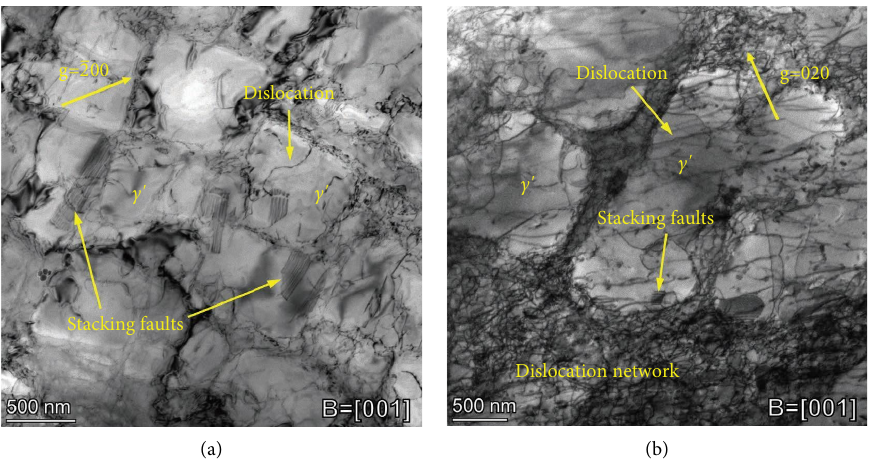
Figure 9: TEM images showing the confguration of SFs and dislocations in as-cast (a) and HIP1175